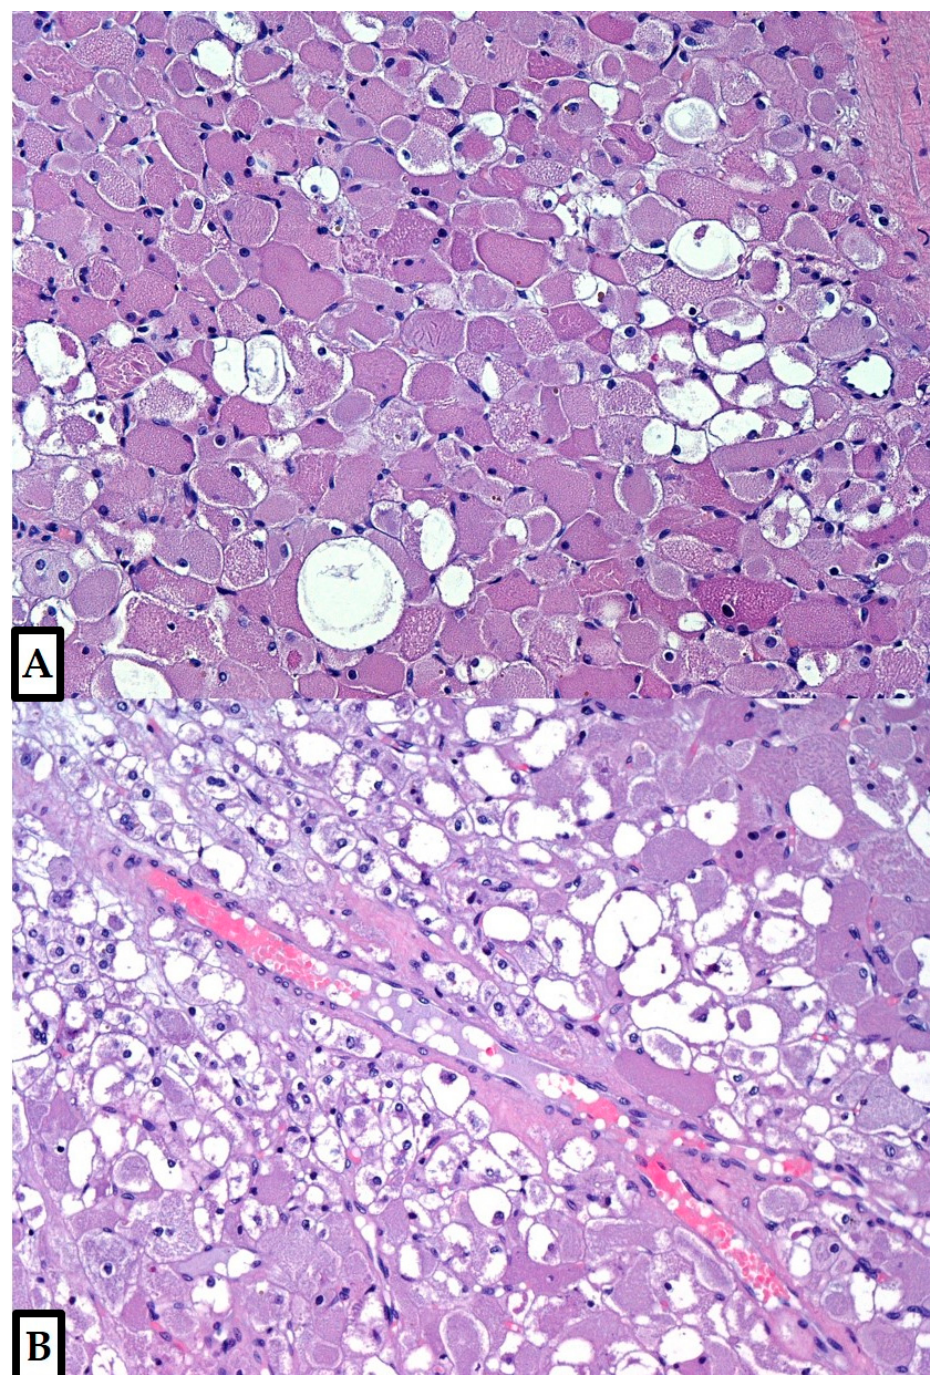
Figure 3. The tumor was composed of large polygonal cells of variable size and shape, with abundant granular eosinophilic cytoplasm; vacuolated cells (spider cells) were usually dispersed through the tumor ( A ), occasionally concentrated in some areas ( B ). Vascularization included small, some- times dilated capillaries and occasional ectatic medium-sized vessels (Hematoxylin and Eosin, 10×; previously unpublished, original photos).